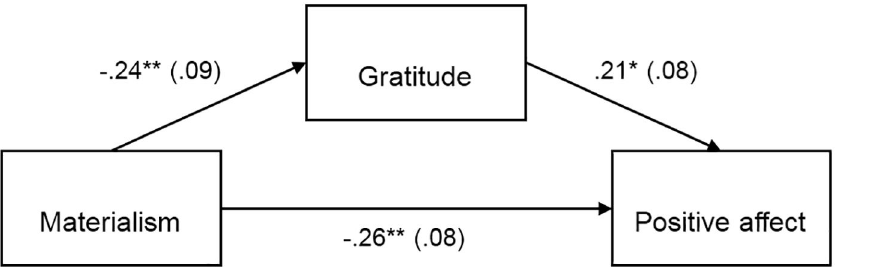
Figure 3. Materialism indirectly predicts positive affect through its relationship with gratitude, b = -.05, SE = .03, 95% CI [-.13, -.01]. Unstandardized coefficients shown with standard error in parentheses. * p < .05. ** p <